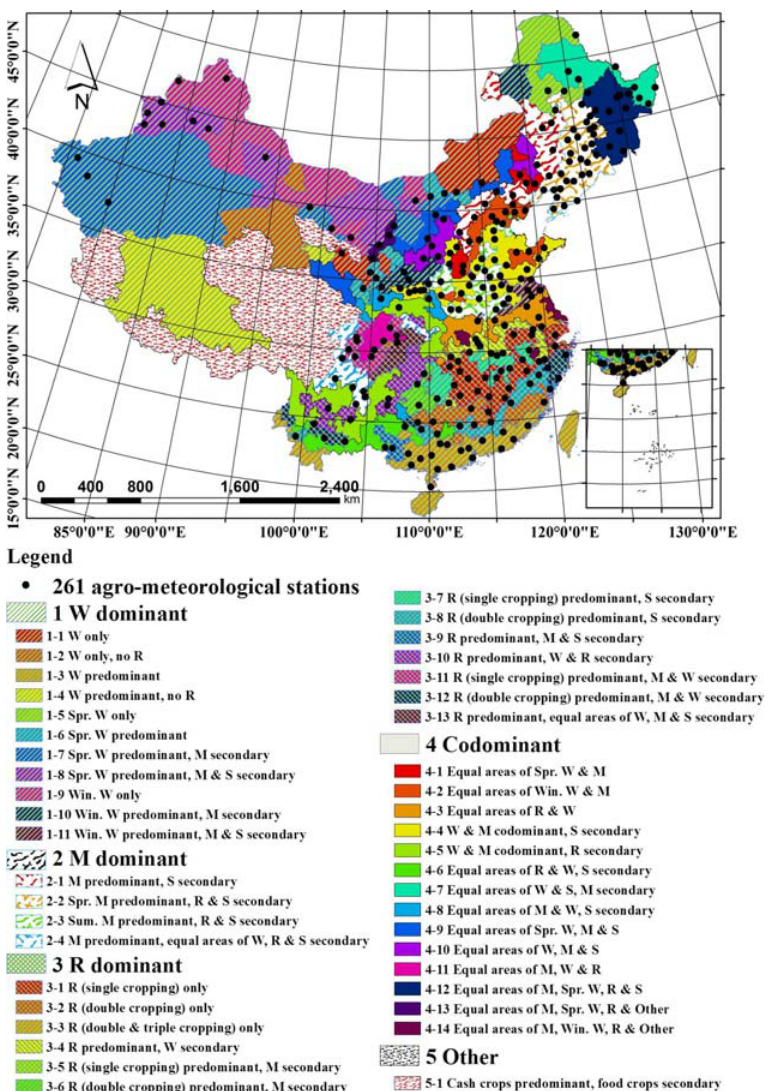
Figure 2. Map of agro-meteorological stations and crop proportion zones in China. W = wheat, Spr. W = spring wheat, Win. W = winter wheat, M = maize, Spr. M = spring maize, Sum. M = summer maize, R = rice, S =